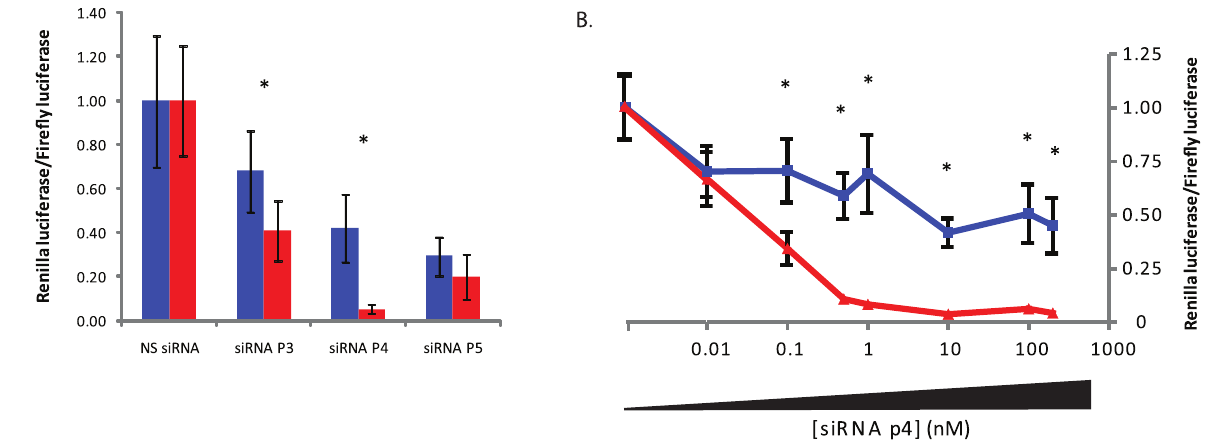
Figure 5. Screening of LRRK2 G2019S-targeting siRNAs against dual-luciferase targets. A) Dual-luciferase assays at 48 hrs with stated siRNAs targeting the G2019S LRRK2 mutant following co-transfection with wild-type (blue lines) or mutant (red lines) luciferase targets. B) Dual- luciferase assays at 48 hrs with siRNA p4 targeting the G2019S LRRK2 mutant at stated concentration following co-transfection with wild-type (blue lines) or mutant (red lines) luciferase targets. Values represent mean ratios of Renilla :Firefly luciferase + / 2 S.D. from n=6. Values are normalized to cells transfected with non-specific shRNA and respective luciferase target. *=P , 0.05 relative to respective normalising control.